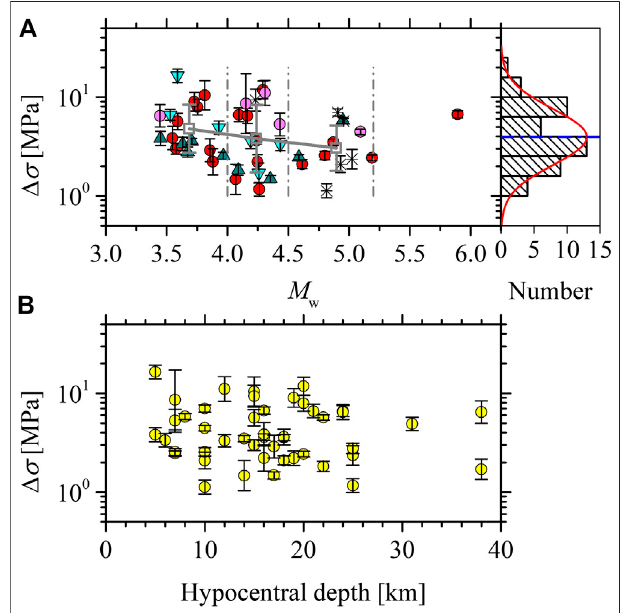
FIGURE 7 | Seismic moment ( M 0 ) vs. corner frequency ( f c ). Squares, circles, and triangles represent the earthquakes considered in this study, the 2008 Wenchuan (Wang et al., 2018), and the 2013 Lushan (Wen et al., 2015) seismic sequences, respectively. The M 0 ∝ f c − 3 scaling relation corresponding to constant stress drops 0.1, 1.0, and 10.0 MPa, respectively, following the theoretical model of Brune (1970), is represented by the dotted- dashed lines.